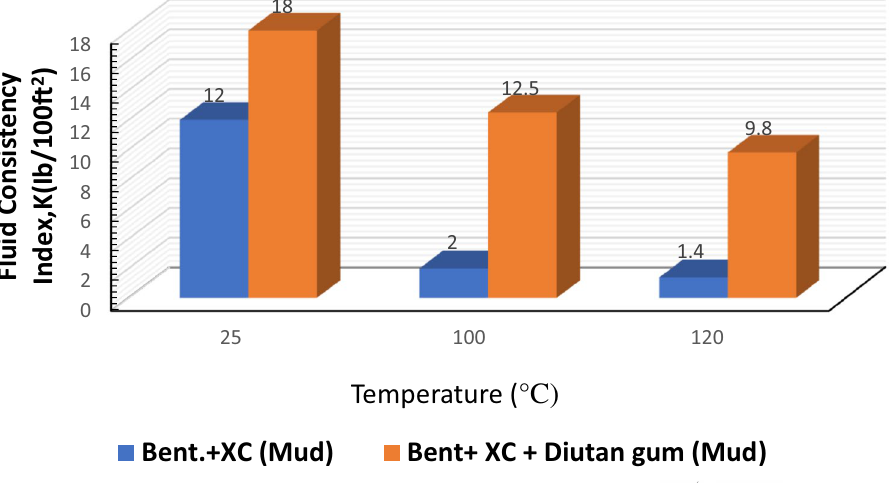
Fig. 6 Effects of temperature on the fluid consistency indexes, K s , of the fluid